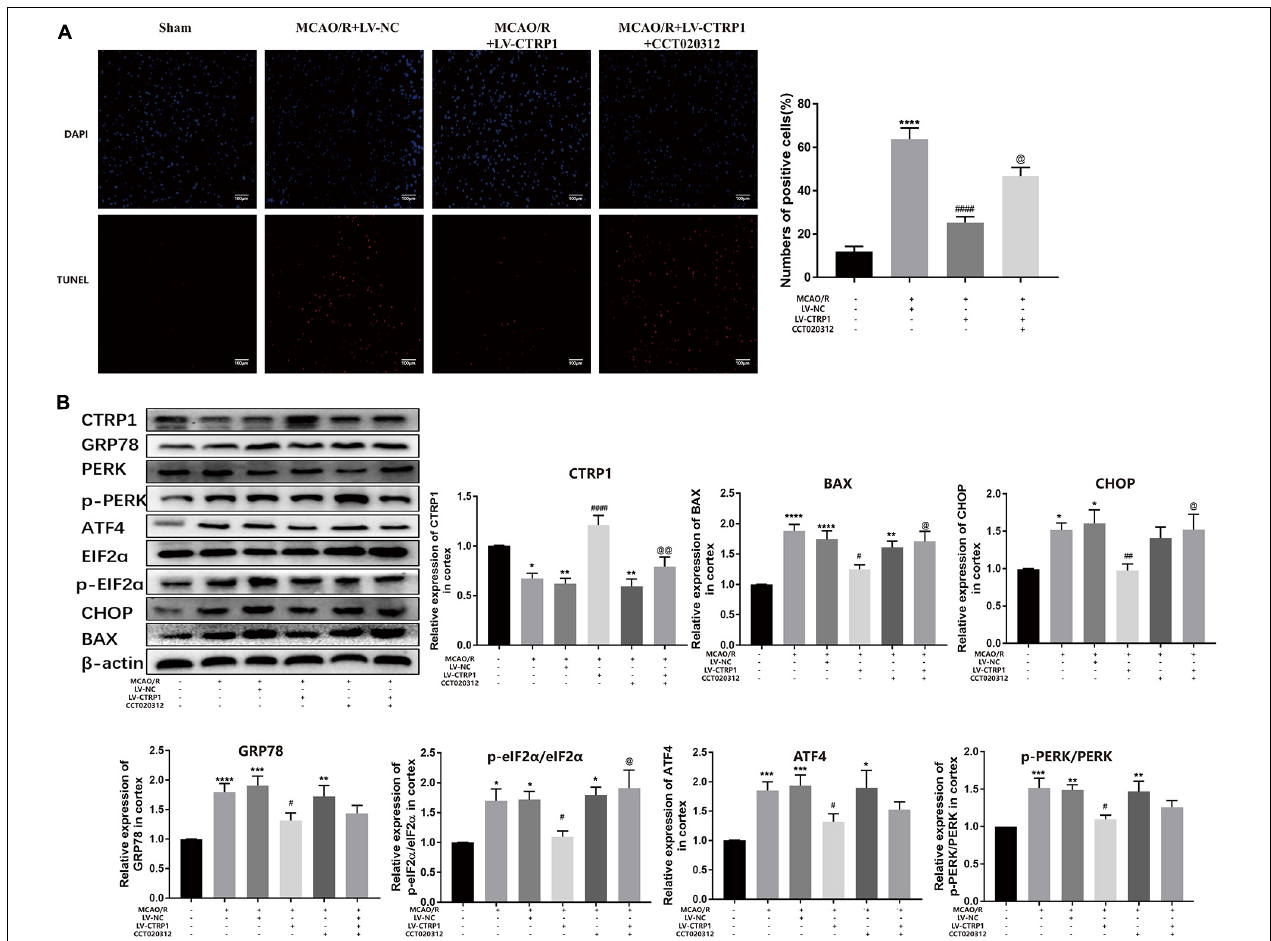
FIGURE 7 | The function of CTRP1 on apoptosis and PERK signal pathway was inhibited by CCT020312. (A) Apoptosis was analyzed by TUNEL, n = 3 per group. The representative images were acquired under × 200 magnification, scale bars = 100 µ m. (B) Western blot analyzed the expression CTRP1, BAX, CHOP, GRP78, ATF4, p-PERK, PERK, p-eIF2 α , and eIF2 α in the cortex. n = 6 per group. **** p < 0.0001, *** p < 0.001, ** p < 0.01, * p < 0.05 vs. sham group, #### p < 0.0001, ## p < 0.01, # p < 0.05 vs. MCAO/R + LV-NC group, @@ p < 0.01, @ p < 0.05 vs. MCAO/R + LV-CTRP1